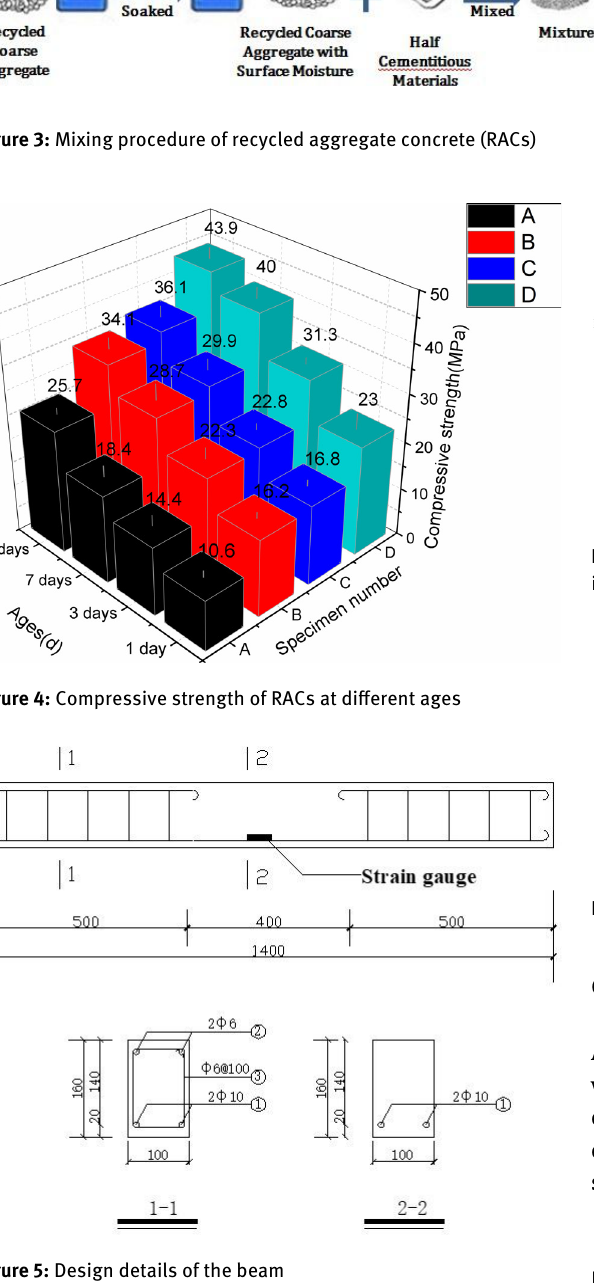
mixed with fine aggregates and another half of cementi- tious materials for another 30s. Finally, the mixing water was added into and mixed for 120s. Thus the fresh RACs after nano-strengthening and mixing were produced and casted to perform the experiments.